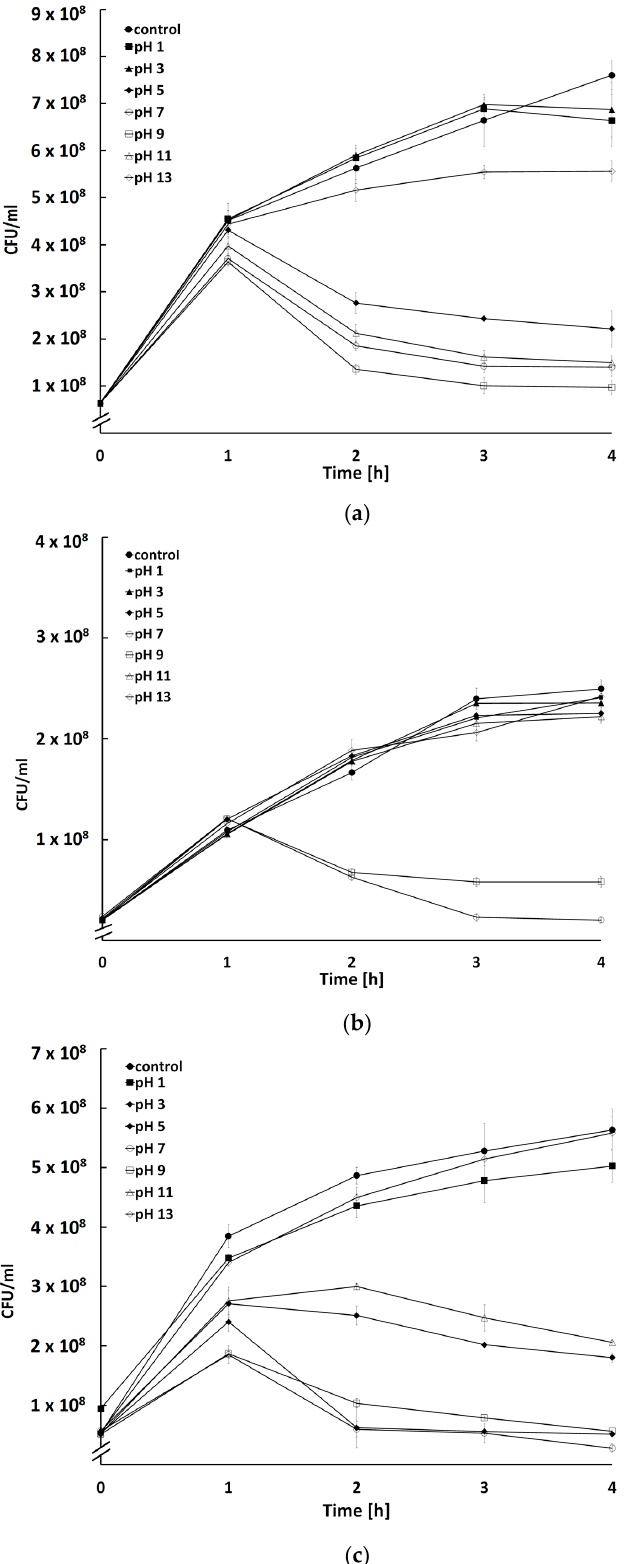
Figure 7. Bactericidal activity of phages BF9 ( a ), BF15 ( b ), and BF17 ( c ) pre-incubated at different pH on count of the host strain. Each data point represents the mean and standard deviation of three different